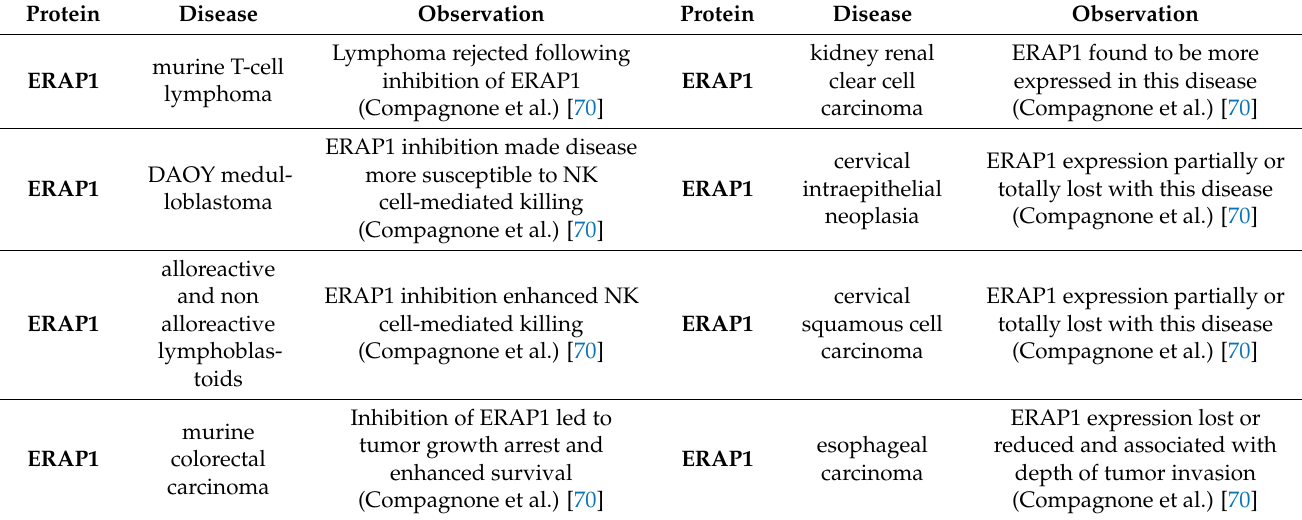
Table 1. Various cancers associated with ERAP, the bolded proteins, are broken down into the following bolded sections: disease type, its associated isoform, and its interaction regarding the aforementioned